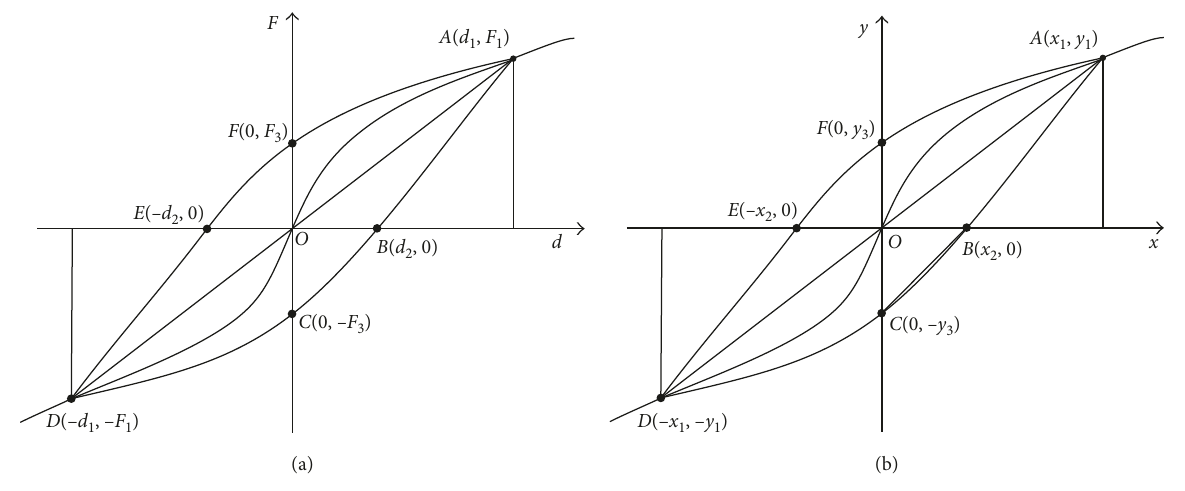
Figure 1: Proposed hysteretic loop model. (a) F − d . (b) y − x .